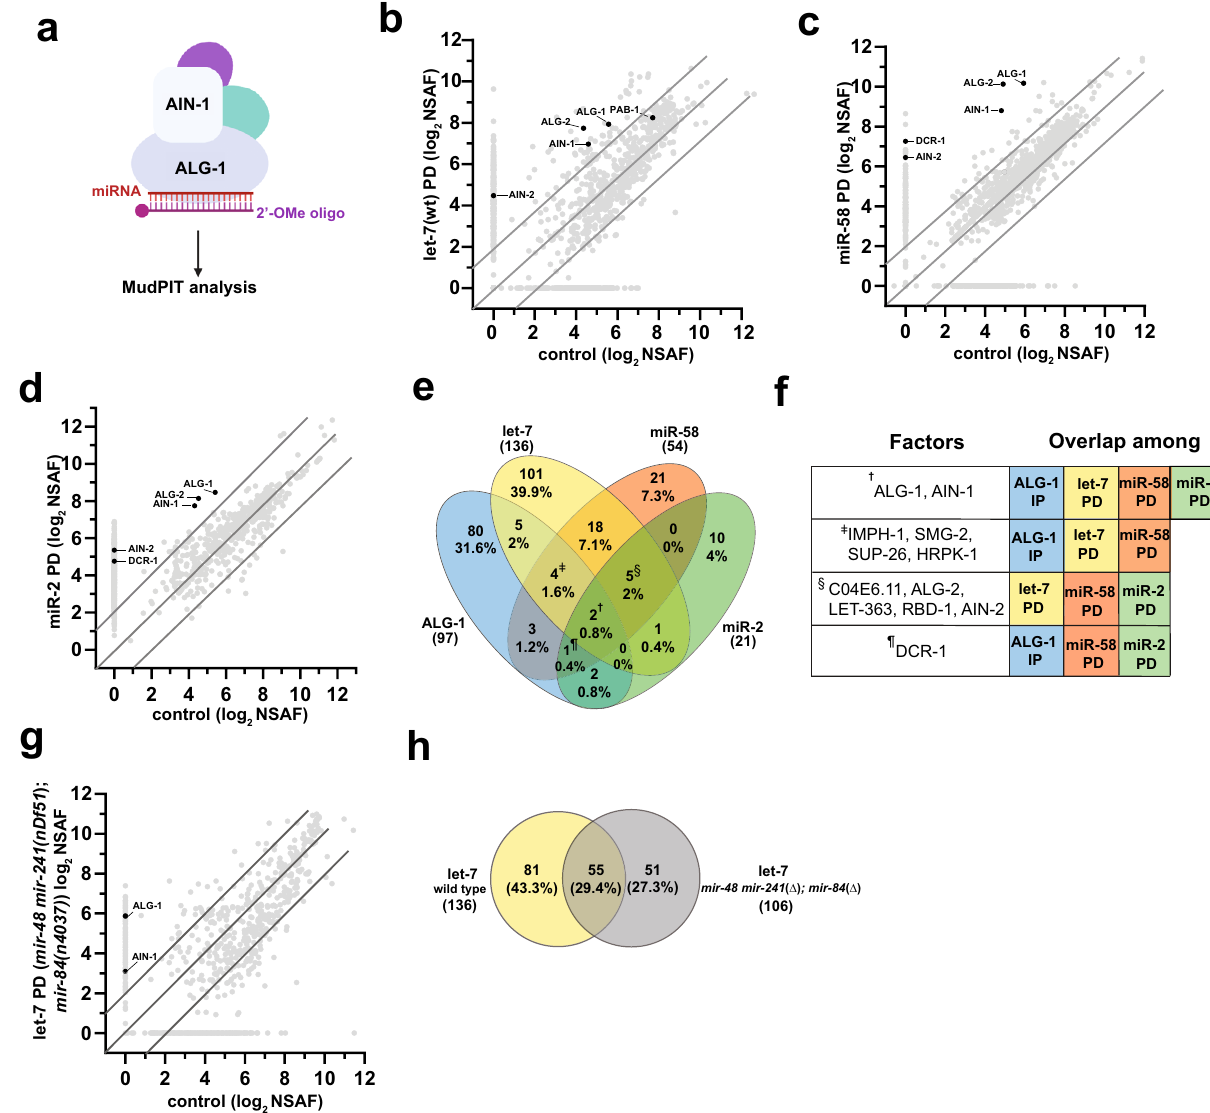
Figure 1. miRNA pulldowns (PDs) identify putative physical interactors of miRNA complexes. ( a ) Protein complexes associated with miRNAs were isolated using 2 ′ -OMe modified oligonucleotides complementary to the miRNA of interest and subjected to MudPIT mass spectrometry analysis (drawn using BioRender (biorender.com)). ( b – d ) Average Normalized Spectral Abundance Factor (NSAF) values of factors identified in pulldown experiments (Y-axis) are plotted against that of corresponding scrambled oligo controls (X-axis) for ( b ) let-7 PD, ( c ) miR-58 PD and ( d ) miR-2 PDs. Highlighted in black are key miRISC components and components of miRNA biogenesis machinery. ( e ) Venn diagram showing the number of factors that passed a set of criteria to qualify as a putative interactor (for description of criteria, see “Methods”). Percentages shown here are percentage of total number of proteins (308) that passed the criteria in interaction datasets including ALG-1 19 . Proteins commonly co-precipitated with † ALG-1, let-7, miR-58, and miR-2, ǂ ALG-1 IP, let-7 PD, and miR-58 PD, § let-7 PD, miR-58 PD, miR-2 PD, and ¶ ALG-1 IP, miR-58 PD, and miR-2 PD. ( f ) Factors commonly identified in two or more interaction datasets include core miRNA machinery components. Symbols in the left column correspond to overlapping protein populations in ( e ). Colored boxes show which IP or PD precipitated the proteins listed in the left column. ( g ) NSAF values of proteins identified in pulldowns with let-7 complementary oligonucleotide from mir-48 mir-241(nDf51); mir-84(n4037) mutant animals, plotted against NSAF of proteins identified in scrambled oligo control. ( h ) let-7 complementary oligonucleotide precipitates a partially overlapping set of factors from let-7 -family miRNA deletion